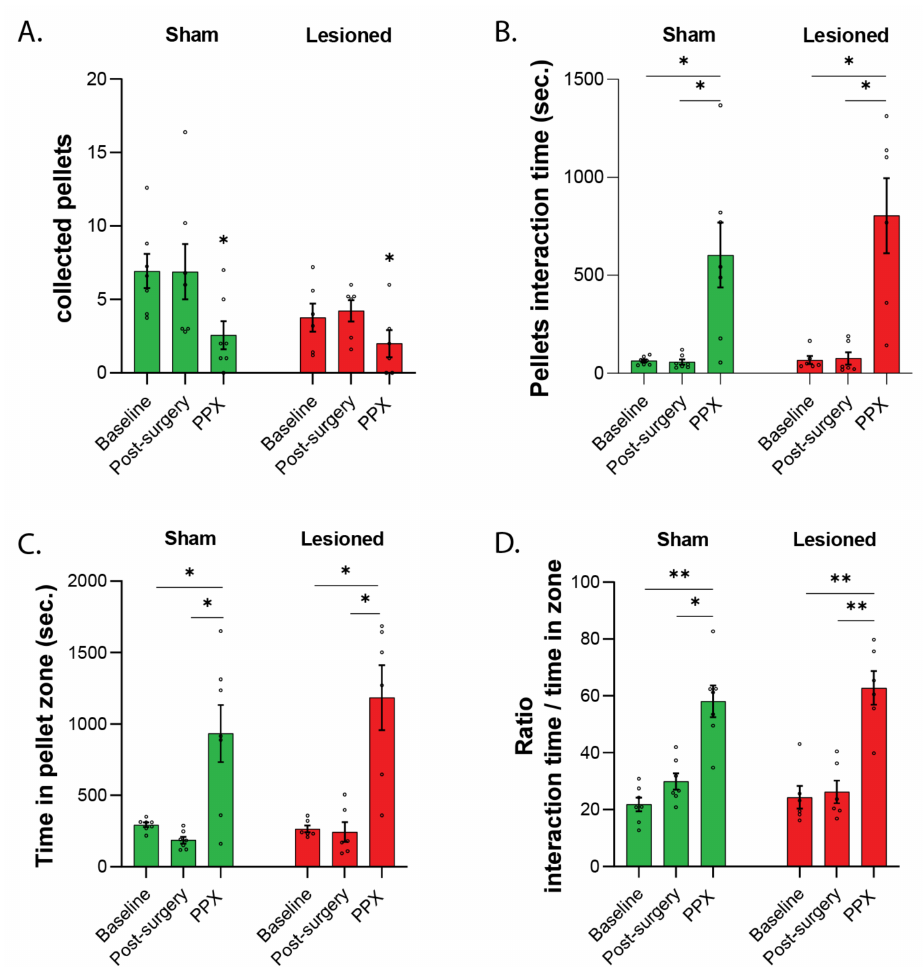
Figure 3. Hoarding (experiment 1). ( A ). Number of food pellets collected in the home cage at baseline, 9 weeks post-surgery (Off drug) and after 10 days of treatment with PPX. *, p < 0.05 vs. post-surgery. ( B ). Time spent performing interactions with food pellets. *, p < 0.05; **, p < 0.01. ( C ). Time spend in the zone containing food pellets. *, p < 0.05. ( D ). Ratio of the time spent interacting with food pellets over the time spent in the food pellet zone. *, p < 0.05; **, p <